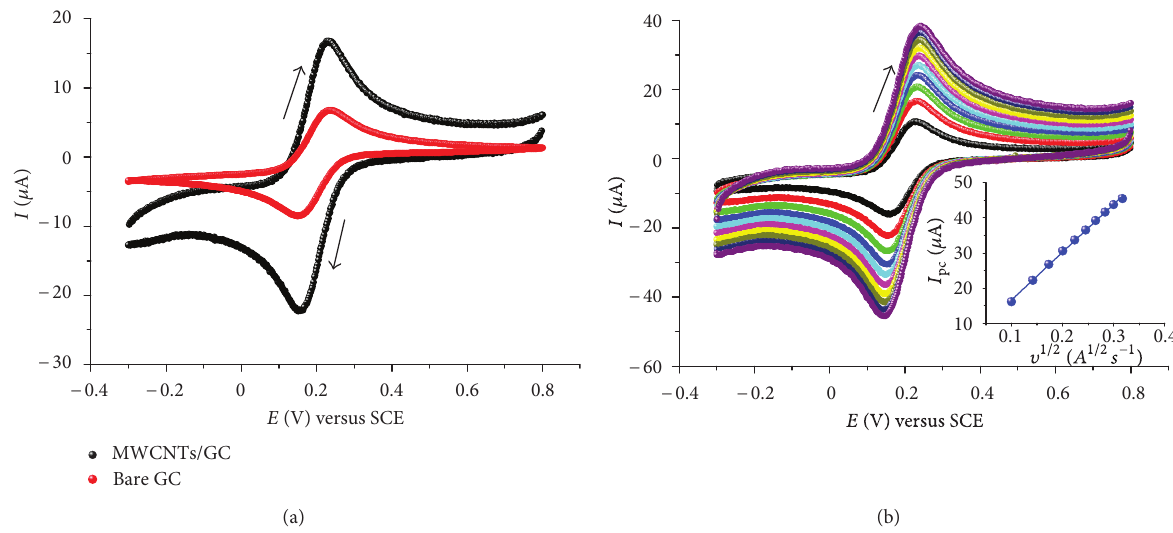
F3:(a)CVsofthebareGCandMWCNTs/GCelectrodesin5mMK